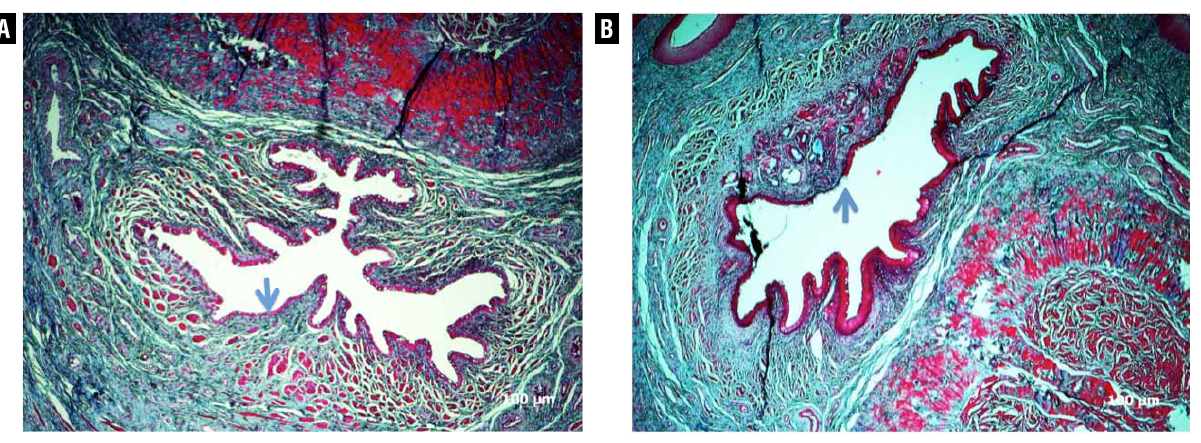
Figure 4 - A - Photomicrography of the urethra - group I animal, postoperative day 14, Blue arrow = epithelium Masson’s tri- chrome, 25x. B - Photomicrography of the urethra - Group II animal, postoperative day 14, Blue arrow = epithelium. Masson’s trichrome,